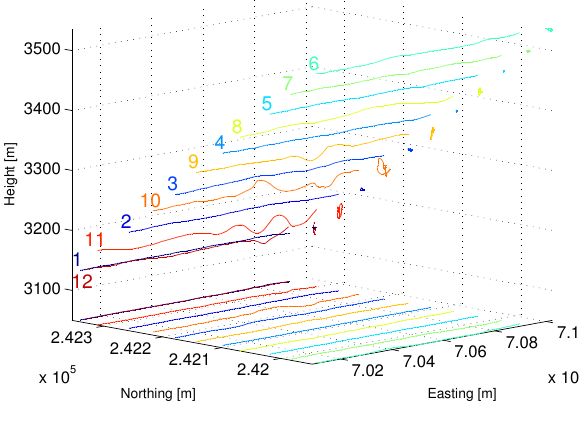
Figure 2. P-band tomographic acquisition pattern consisting of 11 flight tracks + 1 control track. The flight direction is from east to west and the sensor is left-looking. In addition to the actual flight tracks, their projections to the horizontal plane and to the northing-height plane are